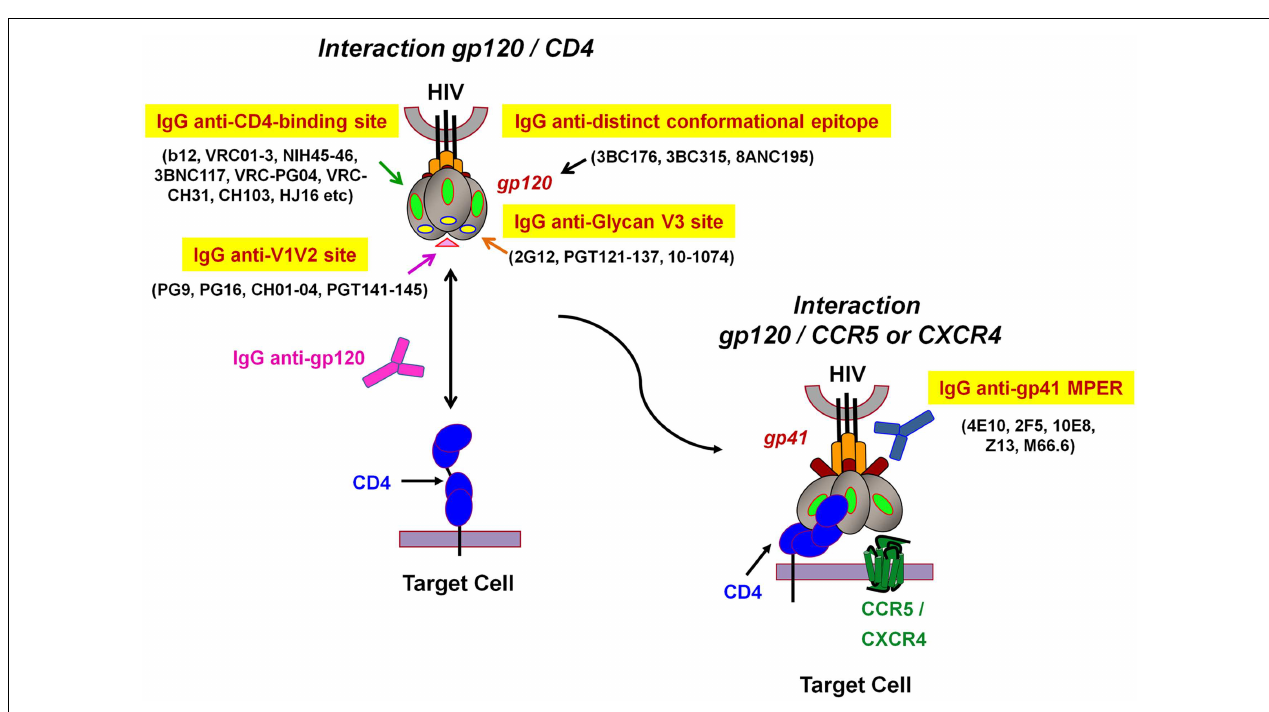
groups: (1) IgG anti-CD4-binding site, (2) IgG anti-V1V2 site, (3) IgG anti- N -linked glycanV3 site, and (4) IgG anti-gp41 membrane proximal external region (MPER).The IgG anti-distinct conformational epitope present on the envelope trimer, remains to be determined (adapted from Dr. Béatrice